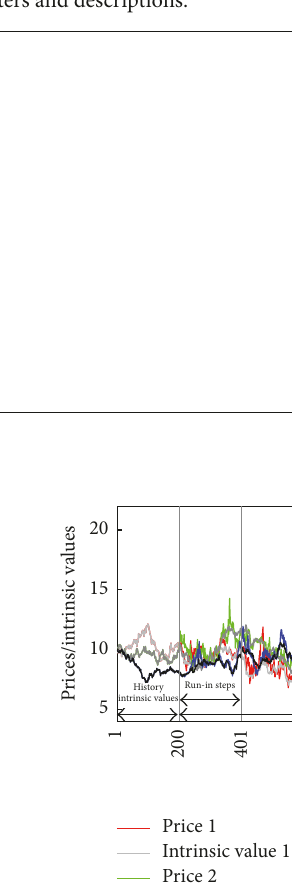
Table 1: Parameters and descriptions.